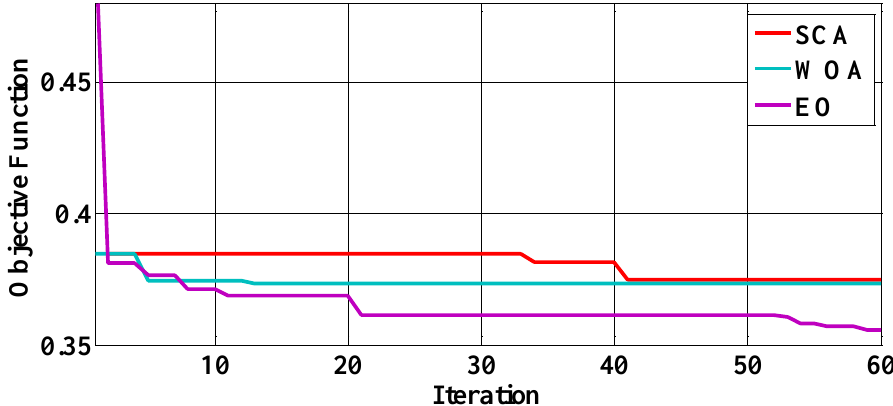
Figure 11. Objective function for sine cosine algorithm (SCA), whale optimization algorithm (WOA), and EO.